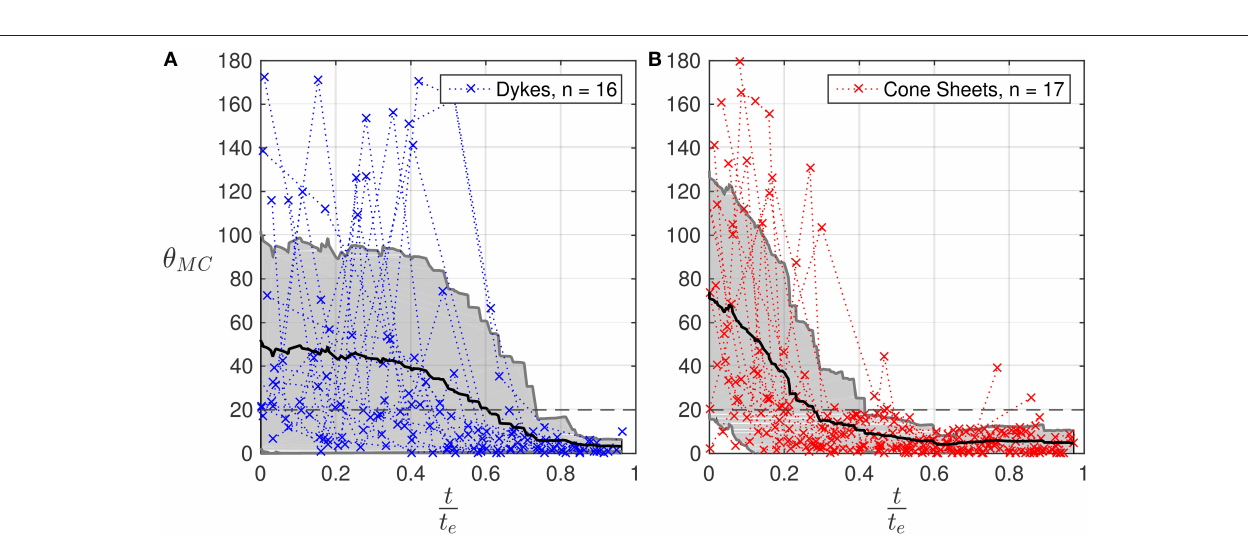
FIGURE 6 | Plots of the rotation angles θ MC between two successive vectors V MC as a function of dimensionless time, t / t e , for the dyke (A) and cone sheet (B) experiments. Each graph displays the corresponding θ MC moving mean (black line) and standard deviation (gray area). For cone sheets, the orientation of the vector generally stabilizes ( θ MC decreases below 20 ◦ , gray dashed line) earlier ( t/t e ∼ 0.3) than for dykes ( t/t e ∼